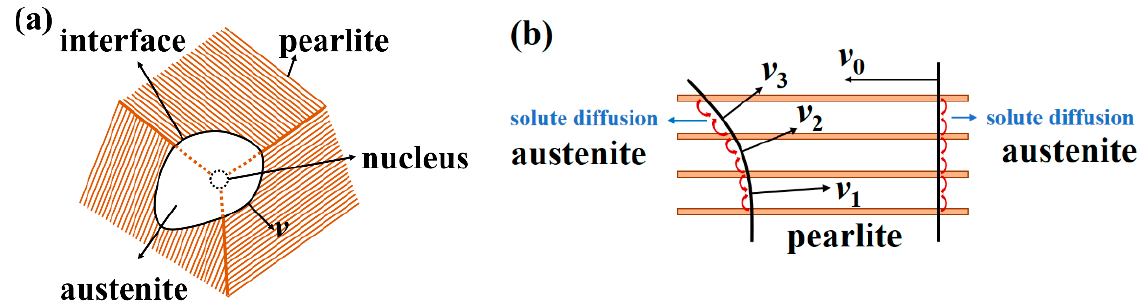
Figure 1. Schematic diagram for the austenitization of lamellar pearlite. ( a ) Growth of an austenite grain in pearlite matrix; ( b ) influence of pearlite lamellae orientation on the γ /P interface moving velocity.